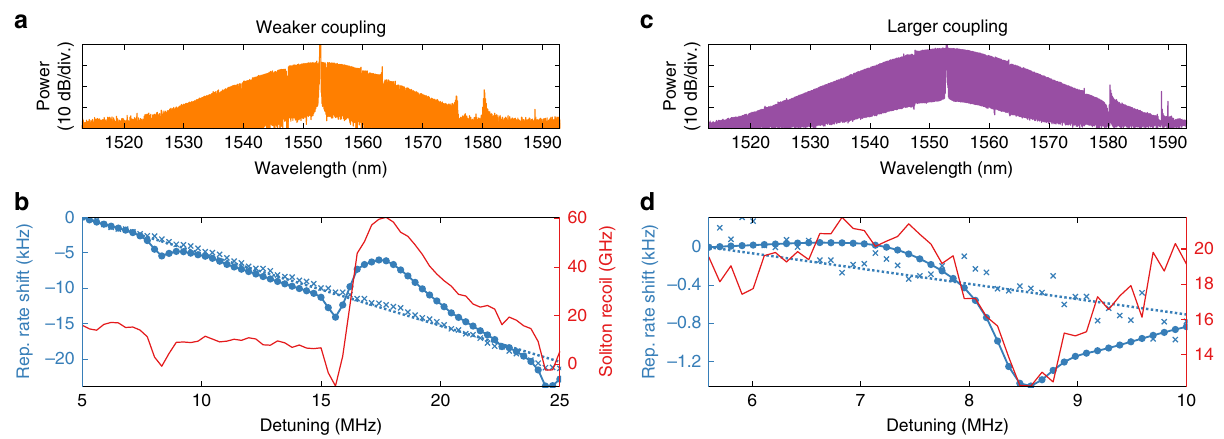
Fig. 4 Optimisation of f K phase noise. a Soliton spectrum for lower coupling case (Detuning 10 MHz). b Evolution of the repetition rate (blue, solid) and of the soliton recoil ( Ω ∕ 2 π ) retrieved by fi tting the optical spectrum (red), in the lower coupling case. The blue crosses and dashed line show the residual repetition rate change after subtraction of the recoil induced shift (using Eq. (2)). c Soliton spectrum for larger coupling case (Detuning 10 MHz). d Evolution of the repetition rate (blue, solid) and of the soliton recoil ( Ω ∕ 2 π ) retrieved by fi tting the optical spectrum (red), in the larger coupling case. The blue dashed line shows the residual repetition rate change after subtraction of the recoil induced shift (using Eq.